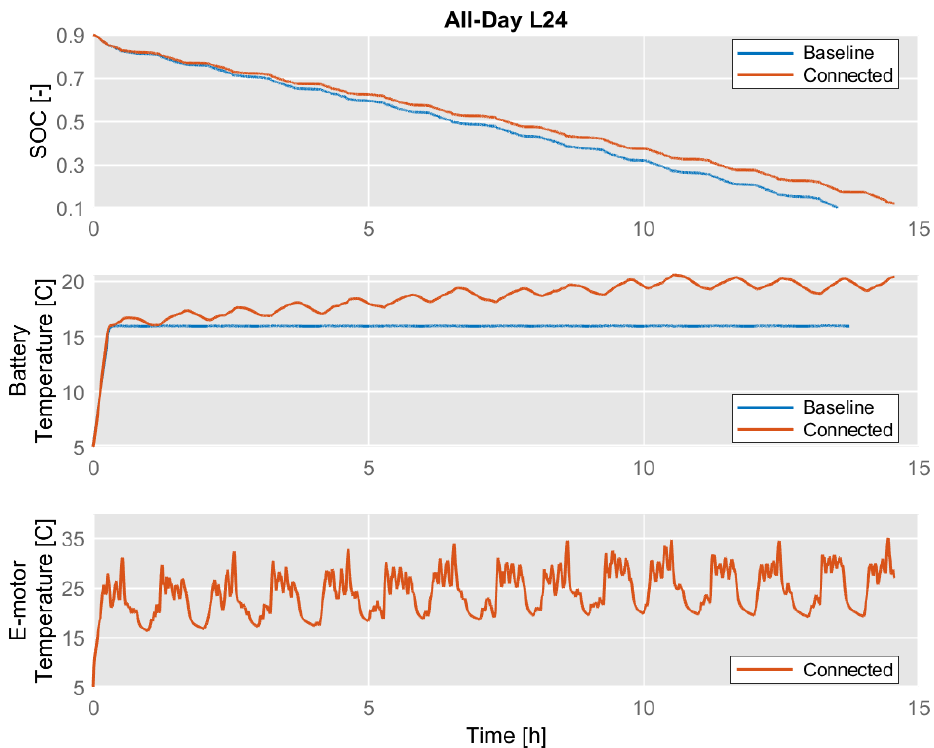
Figure 25. Multivariable comparation between both thermohydraulic configuration throughout time for an all-day driving cycle of bus route 24.